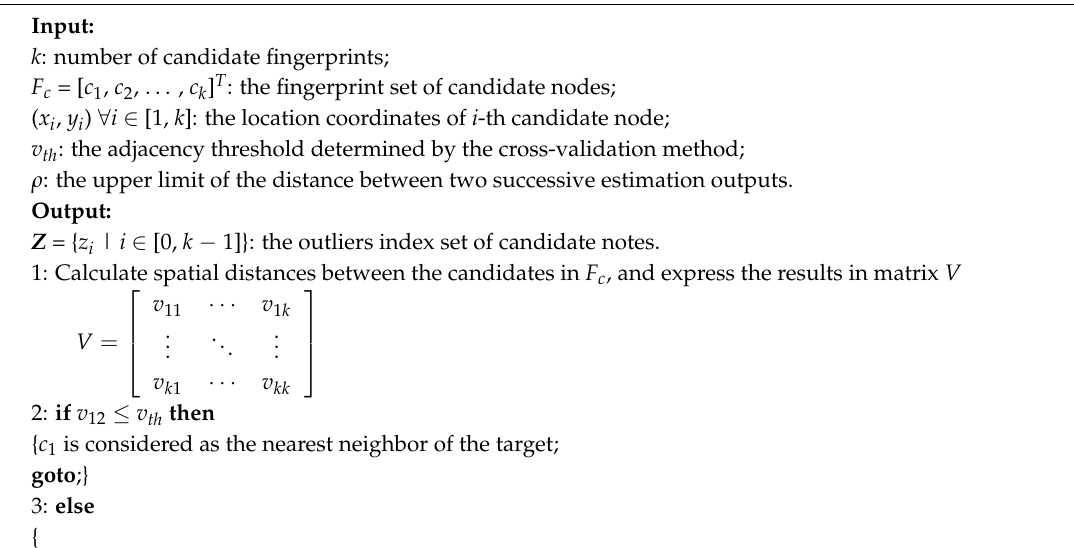
Algorithm 2. Outlier